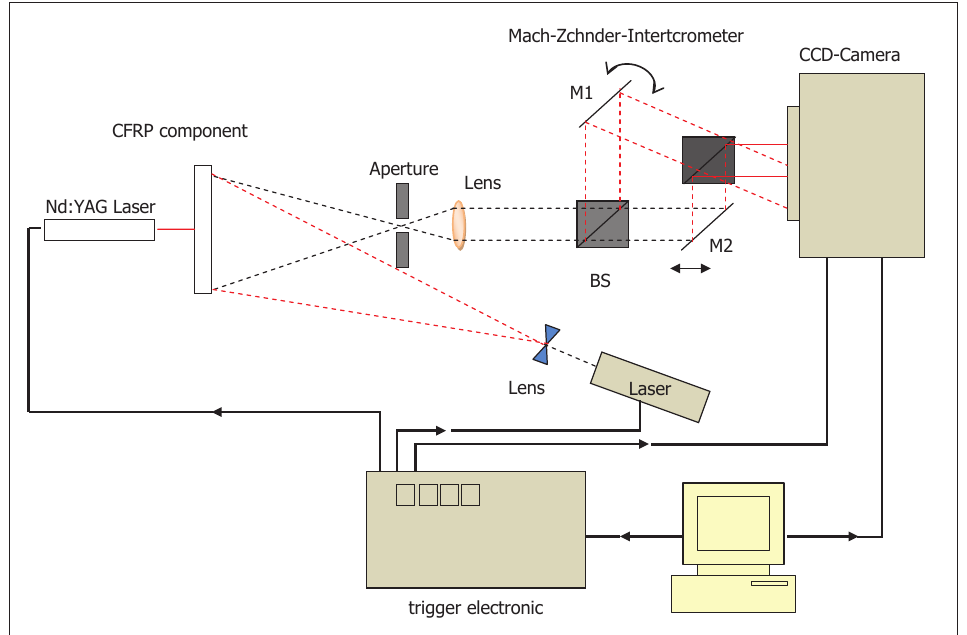
Figure 30. Laser-generated Lamb wave detection with a Mach-Zehnder